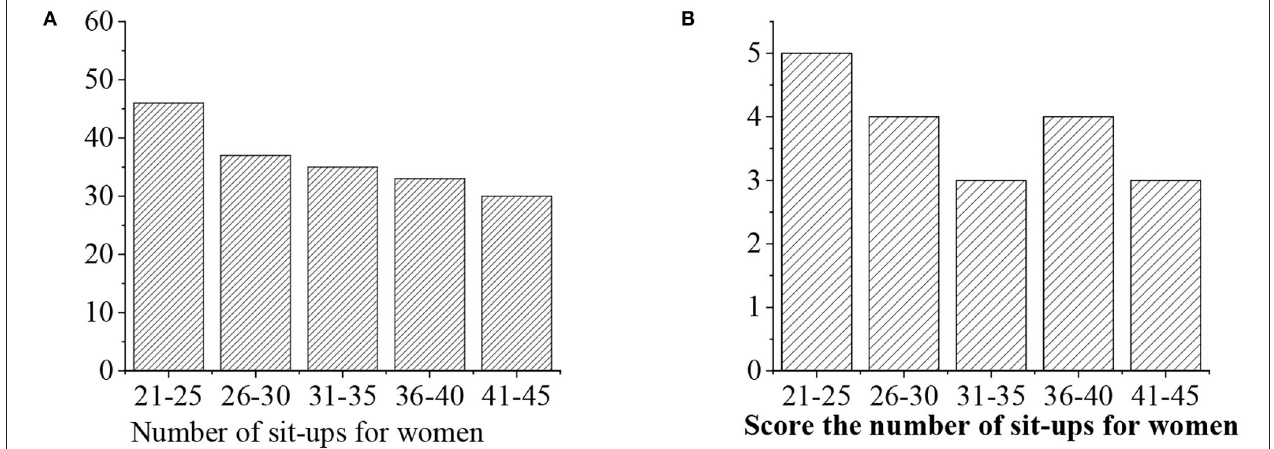
FIGURE 11 | (A) Statistical average sit-ups value for women of different ages. (B) Sit-ups